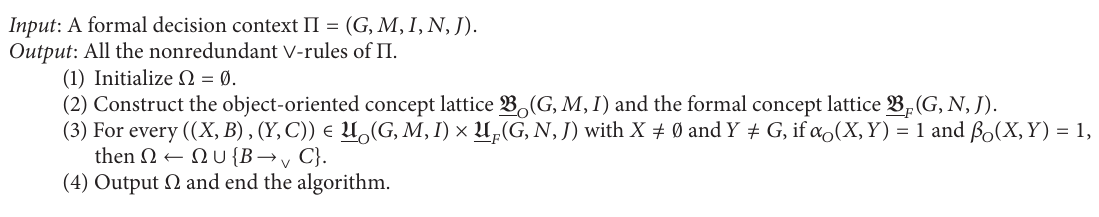
Algorithm 1: Deriving the nonredundant ∨ -rules from a formal decision context.